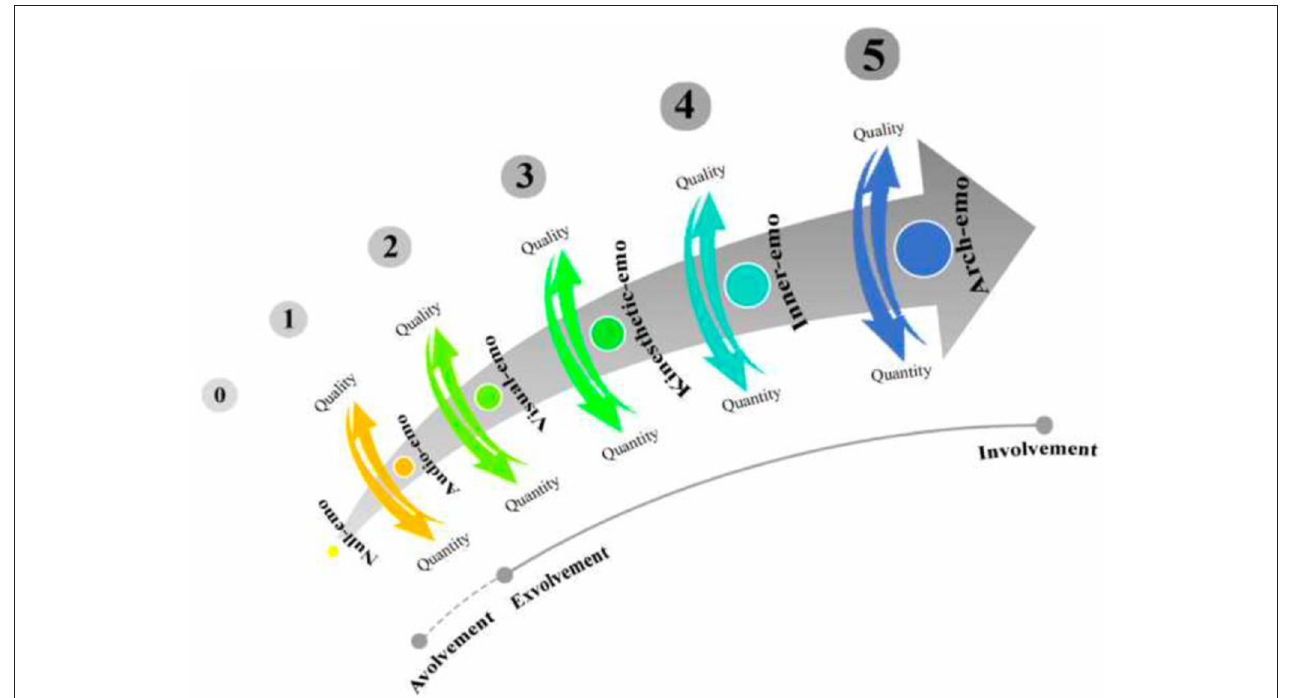
FIGURE 1 | Emotioncy matrix. Adapted from Pishghadam